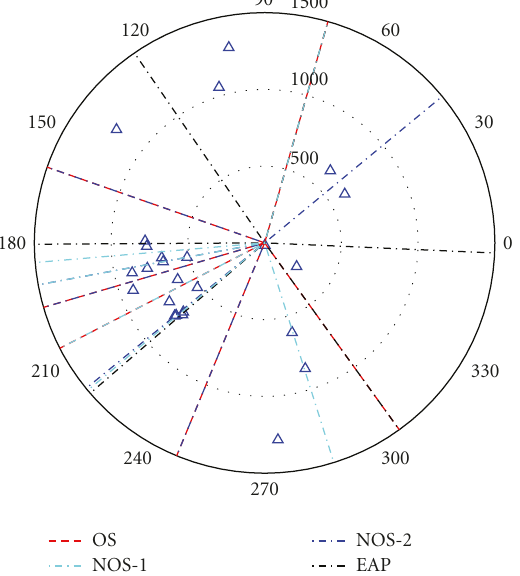
Figure 5: Comparison of optimum sectorization with random sig- nature for uplink and downlink; nonuniform terminal distribution.